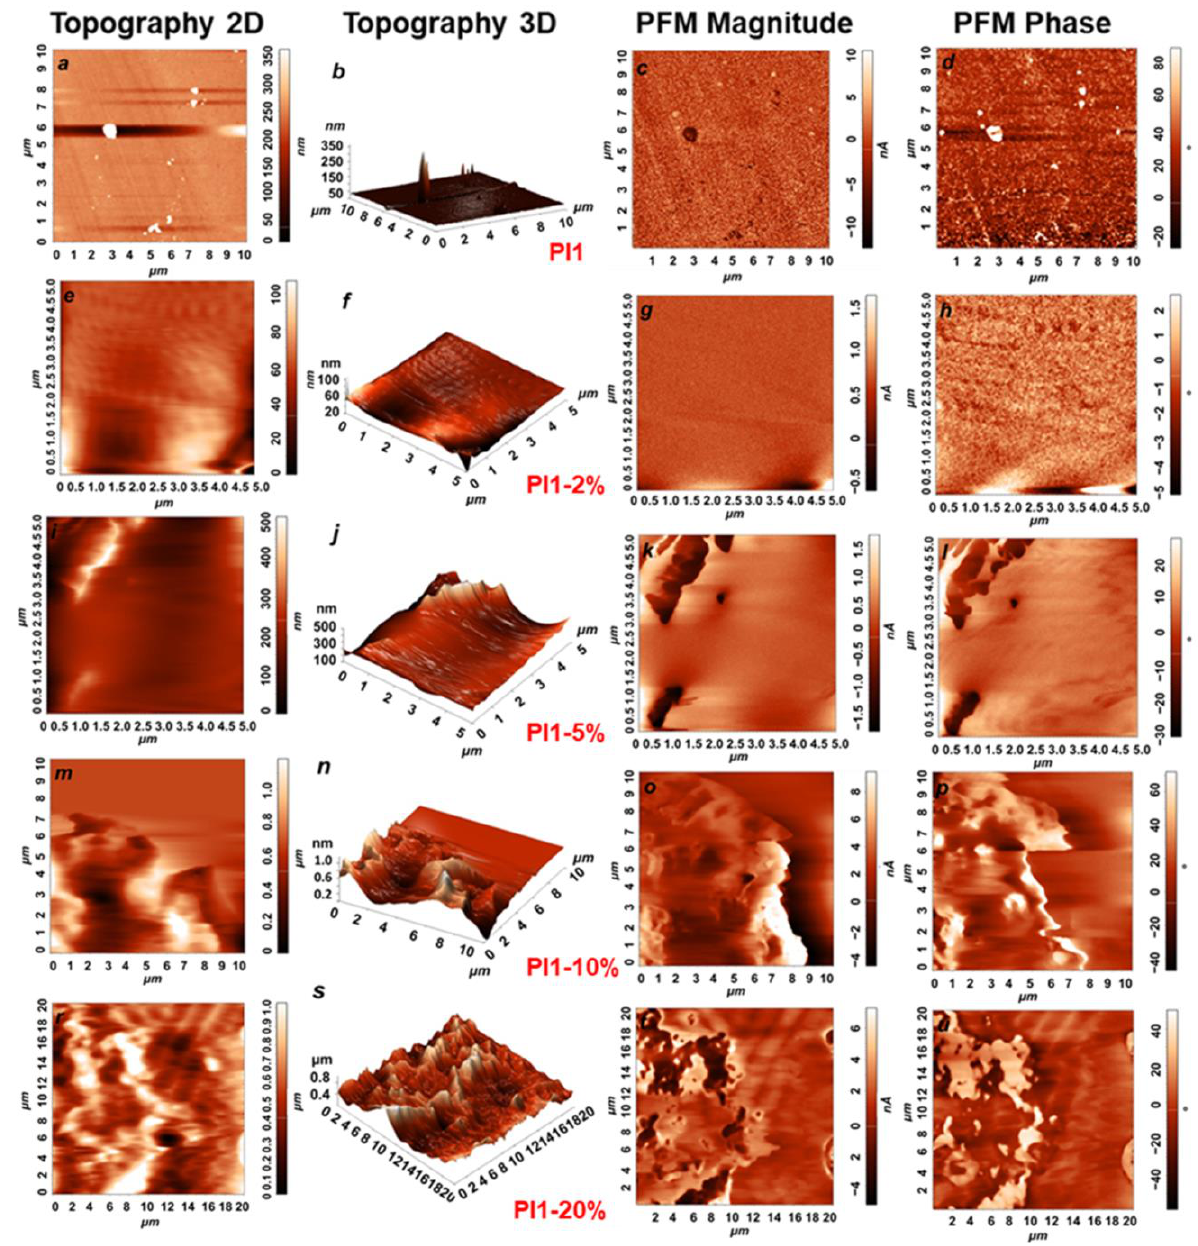
Figure 7. PFM images: surface 2D topography ( a , e , i , m , r ), surface 3D topography ( b , f , j , n , s ), magnitude ( c,g,k,o,t ), and phase ( d,h,l,p,u ) for samples prepared with PI1. Table 4. Roughness and piezoelectric coefficient for the samples tested.